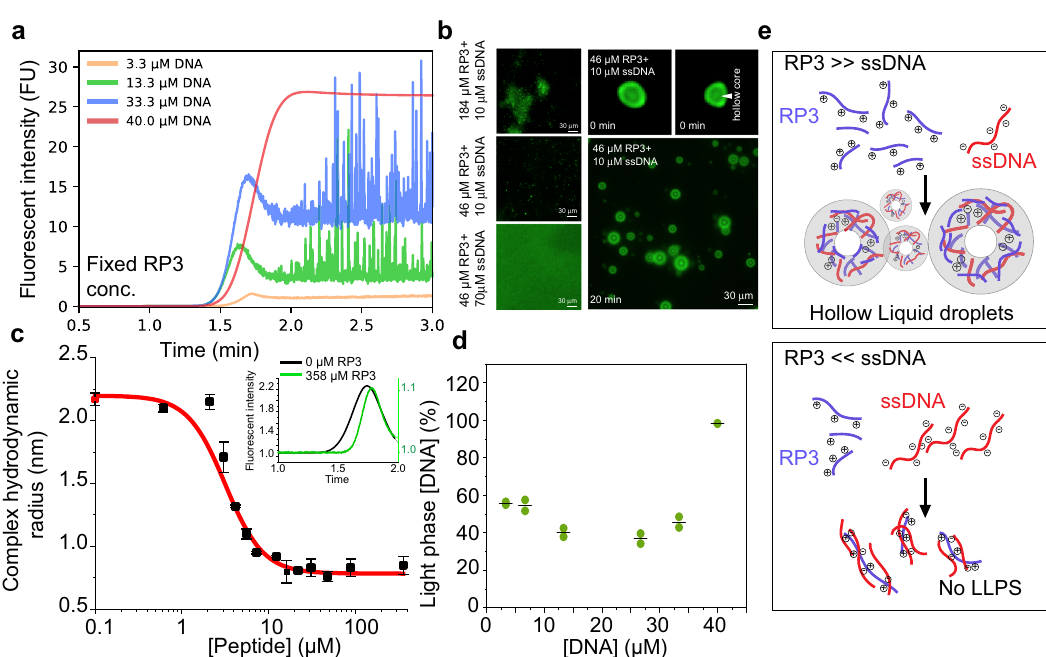
Fig. 4 Coacervation of the arginine-rich peptide RP3 and ssDNA shows non-linear behavior as a function of DNA. a Cap fl ex data showing the titration of 184 µ M RP 3 with increasing concentration of ssDNA (3.3 µ M, orange; 13.3 µ M, green; 33.33 µ M, blue; 40 µ M, red) containing a fi xed ratio of Alexa488 labeled ssDNA (0.17%). As RP 3 does not form droplets on its own, spikes on the traces are only observed at intermediate concentrations before being dissolved at higher ssDNA concentrations. The initial overshoot of the signal under conditions where droplets are observed might arise from droplets in the fast fl ow in the center of the capillary, which then re-dissolved when surrounded only by buffer. b Representative fl uorescence micrographs of RP 3 /ssDNA coacervates in the different regimes showing the disappearance of droplets at high ssDNA: RP 3 ratios. In the intermediate regime, hollow coacervates were observed (right panels). These hollow coacervates grow in size after 20 min incubation at 20 °C indicating liquid-like behavior. n = 2 independent experiments. c FIDA measurements of Alexa488-ssDNA hydrodynamic radius when titrated with RP 3 shows a strong decrease in size upon binding, with an apparent K d = 5.3 ± 0.4 µ M. The red point corresponds to 0 µ M RP 3 and the inset shows Taylor grams with 0 (black) and 358 µ M (green) RP 3 added. Values represent mean ± SD for n = 3 independent experiments. d Using standard curve calibration, the light phase ssDNA concentration is estimated and plotted as percentage of the total concentration of ssDNA. The data represents replicate values and mean (black line) from n = 2 independent experiments. e Schematic showing RP 3 droplets are only formed at intermediate ratios of ssDNA to peptide (upper panel), while an excess of ssDNA presumably saturates the positive charges on RP 3 preventing the formation of the network structure needed for coacervation (lower panel). Source data are provided as a Source Data fi